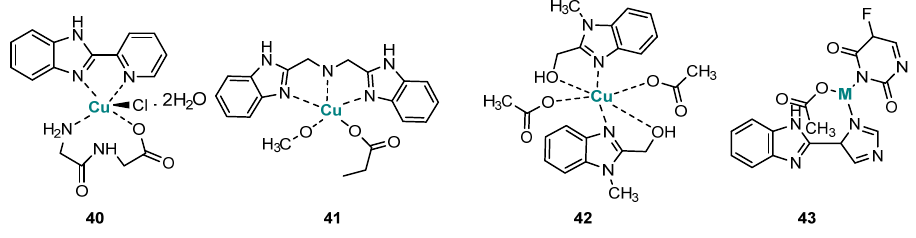
Figure 21. Transition metal complexes with benzimidazole.